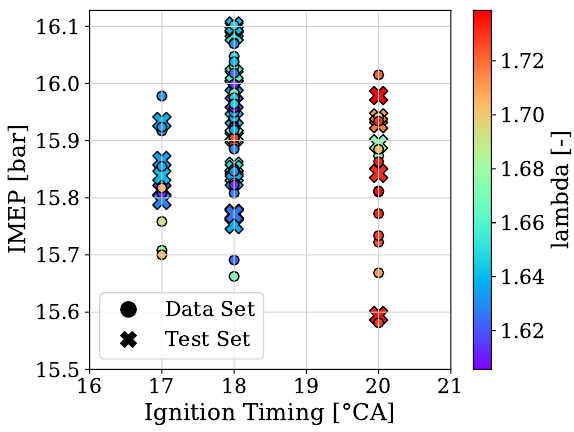
Figure 4. OPs of engine 1.